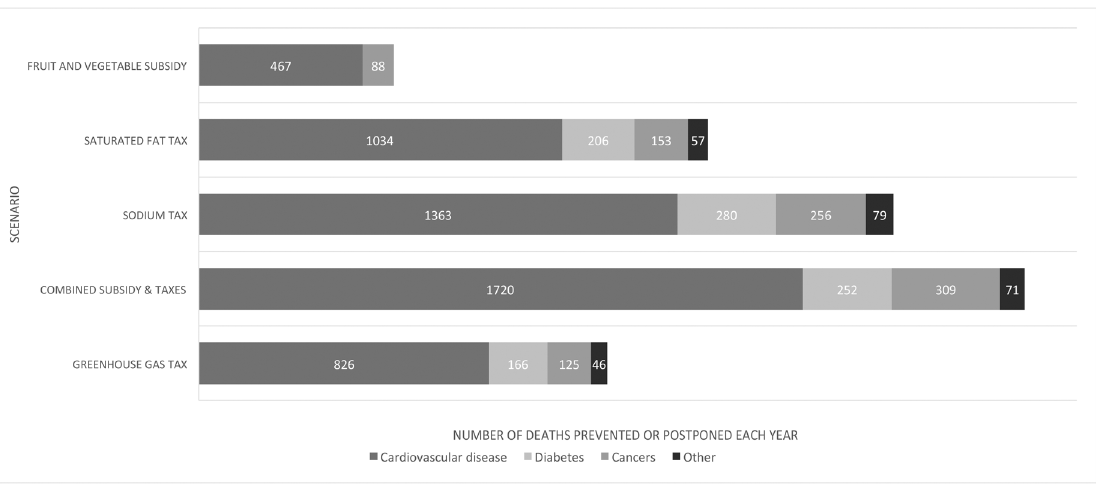
Fig 2. Total number of deaths prevented or postponed in New Zealand each year by five taxation and subsidy